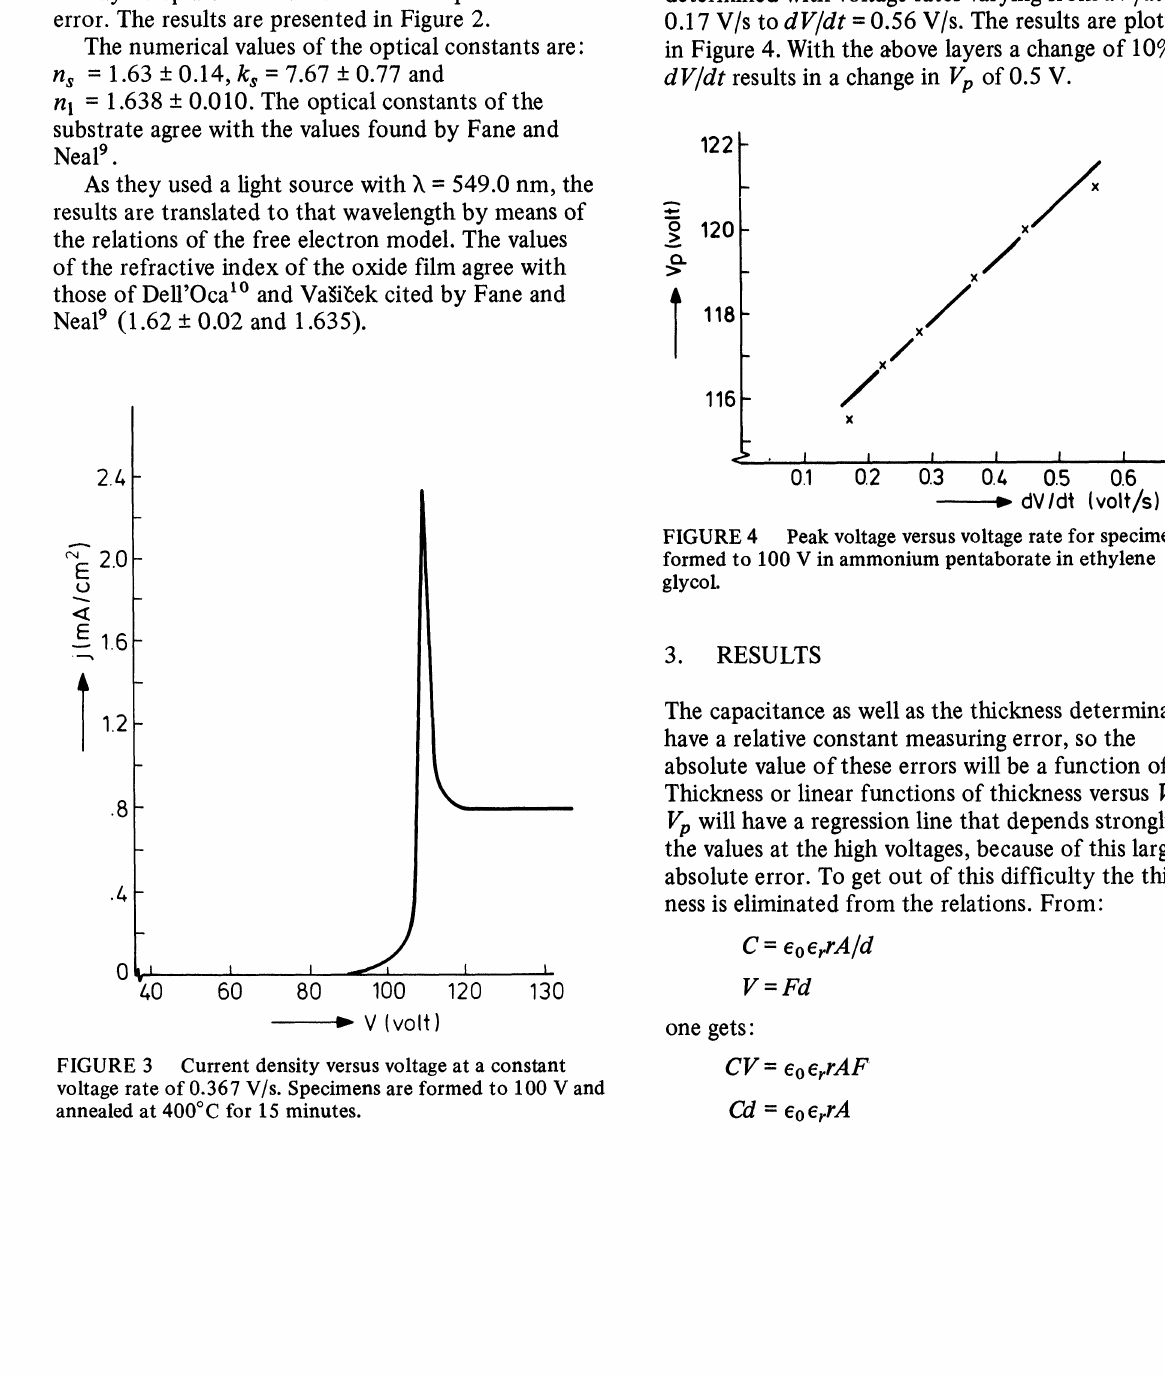
Current density versus voltage at a constant voltage rate of 0.367 V/s. Specimens are formed to 100 V and annealed at 400 C for 15 minutes.